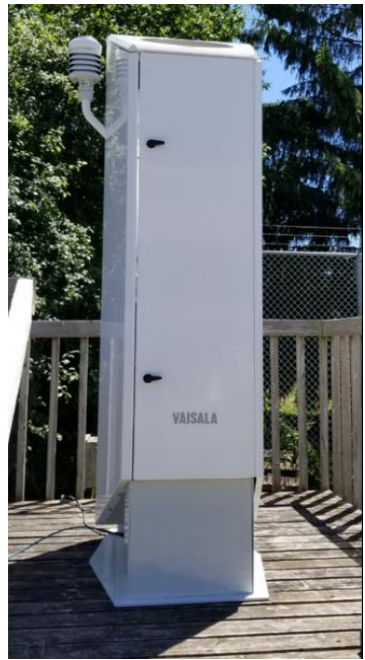
Figure 2. The Vaisala DIAL deployed on an elevated platform at the meteorological test field at ECCC Downsview. ECCC